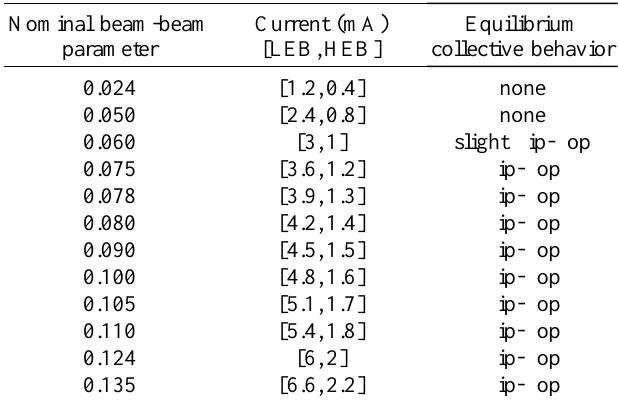
TABLE II. Equilibrium configuration after 10 000 turns (10 damping times). Energies are 3.1 and 9 GeV.